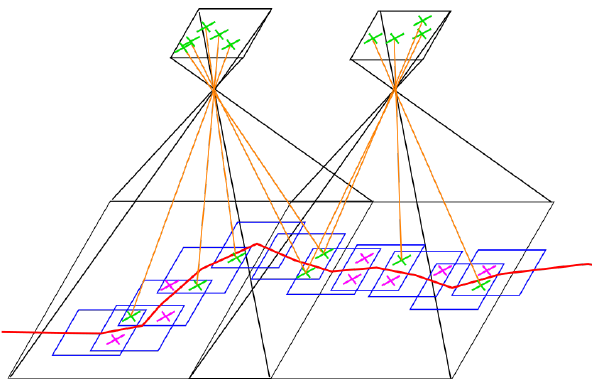
Figure 3. Registration scheme; aerial images (black), MM trajectory (red), projected MM images (blue), inter-MM correspondences (purple), correspondences between MM and aerial images